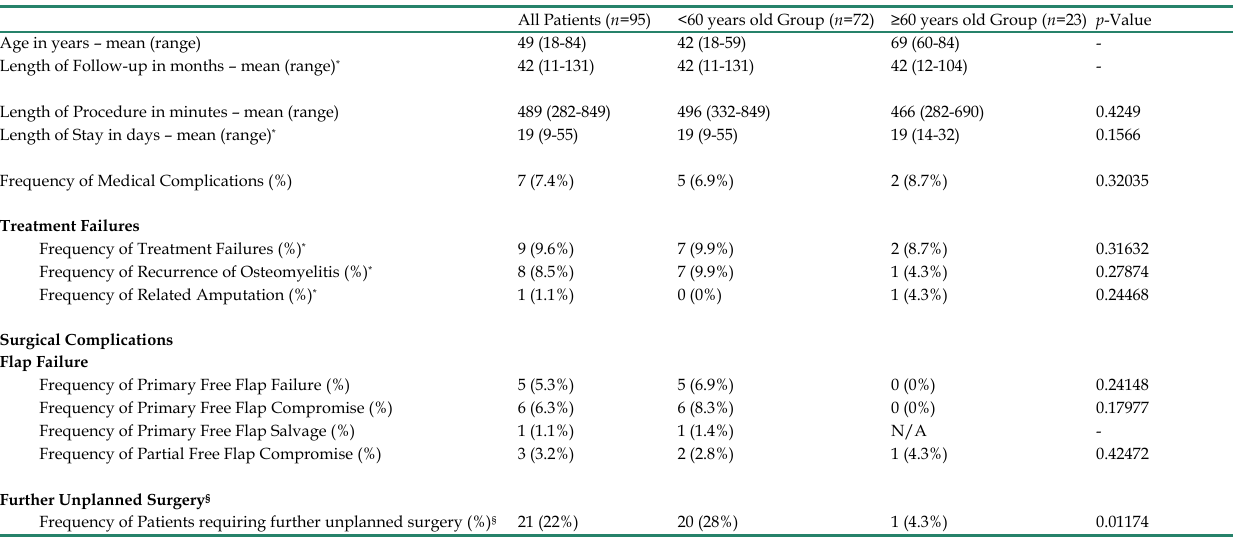
Table 5 : Summary Table of Results.